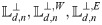
Cell migration through complex microenvironment.Migration of a tumor cell through a dense network of normal cells in the brain. The normal cells were placed in a zig-zag fashion and the chemotactic source was located at the top of the computational domain. (A) A profile of the migratory glioma cell through normal cells (black dashed circles) at t = 0 (red solid), 60 (blue solid), 180 (black solid), 360 (cyan solid), 600 (light blue solid), 960 (green solid) min. (B) Time courses of the averaged speed. (C) Time courses of shape deformations (Ld,n⊥,Ld,n⊥,W,Ld,n⊥,E) of the nucleus. (D) Direction change (angle from the vertical axis) of the cell shown in panel (A) over the time course of 960 min. Positive values indicate that the cell moves in the north-east direction and negative values indicate that the cell moves in the north-west direction. The black arrows and arrowheads in (D) mark the corresponding times at which the cell changes its moving direction.